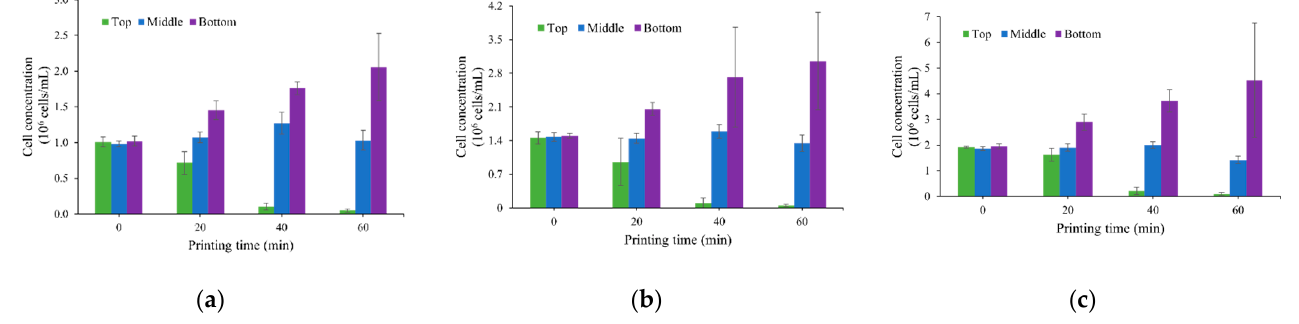
Figure 2. Cell concentrations measured at different regions after different printing time using the bioink composed of 0.5% ( w / v ) sodium alginate and a cell concentration of ( a ) 1 × 10 6 cells/mL, ( b ) 1.5 × 10 6 cells/mL, and ( c ) 2 × 10 6 cells/mL.